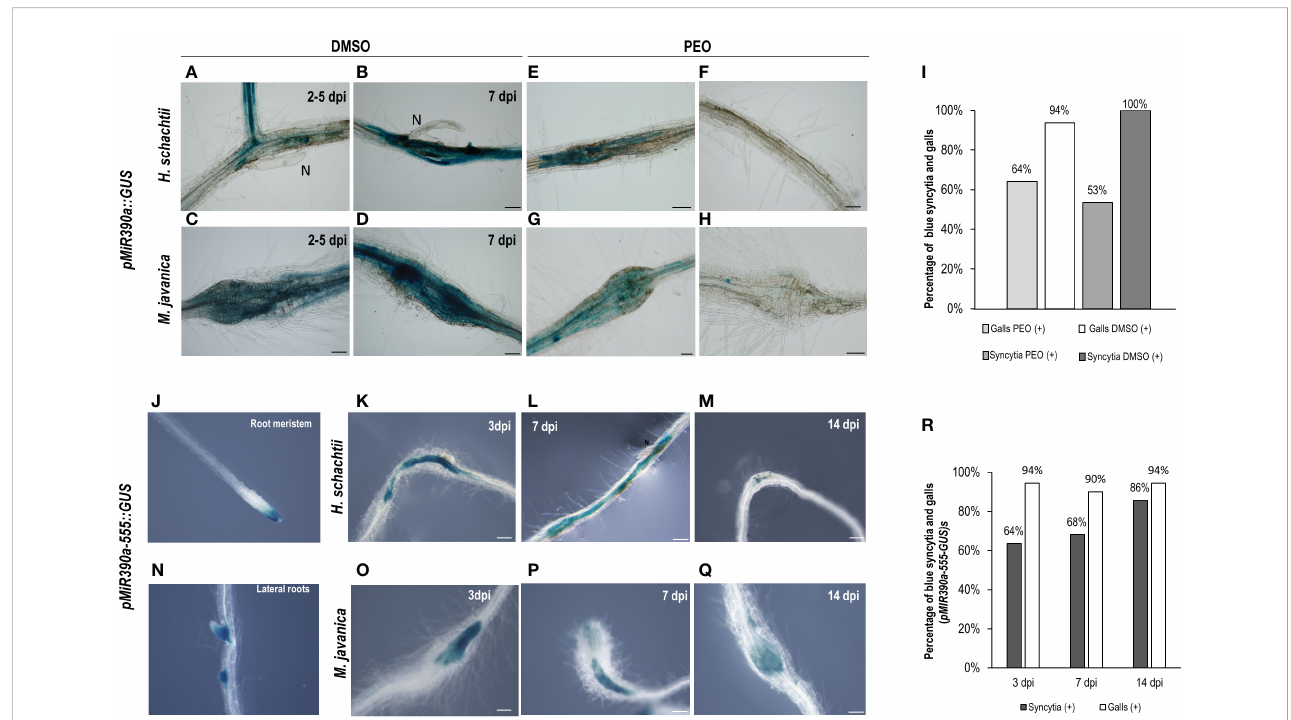
FIGURE 2 pmiR390a::GUS and pmiR390a-555::GUS are active in the infection sites induced by Heterodera schachtii , in galls induced by Meloidogyne javanica in Arabidopsis and partially regulated by auxins. Arabidopsis roots of pmiR390a::GUS infected by H. schachtii or M. javanica with a strong GUS signal at 2 – 5 and 7 days post inoculation (dpi; A – D, respectively ). Treatment with the PEO-IAA (IAA transduction inhibitor) inhibited partially its expression (CNs, B – F and RKNs infection sites, D – H ). Percentage of GUS-stained galls and syncytia (7 dpi) in PEO-IAA treatment respect to the DMSO control (I) . Activation pattern of a deleted version of the promoter pMIR390a-555::GUS in syncytia and galls at 3, 7, and 14 dpi ( K – M and O – Q , respectively) and percentages of GUS-stained RKN and CN infection sites (R) . The expression in uninfected tissues was centred in the root meristem and lateral root primordia, positive controls, as described ( J, N ; Dastidar et al., 2019). Scale bars: 100 μm. At least 13 pmiR390a::GUS independent plants per treatment and 16 pMIR390a-555::GUS plants were assayed by GUS staining. Chi-square analysis, [ c ² (2, 51) = 1.2] and [ c ² (2, 84) = 0.57], indicated that the distribution of GUS-stained CN and RKN infection sites in the pMIR390a-555::GUS line is not signi fi cantly different among the three infection stages, P <0.05. Three independent experiments per line assayed were